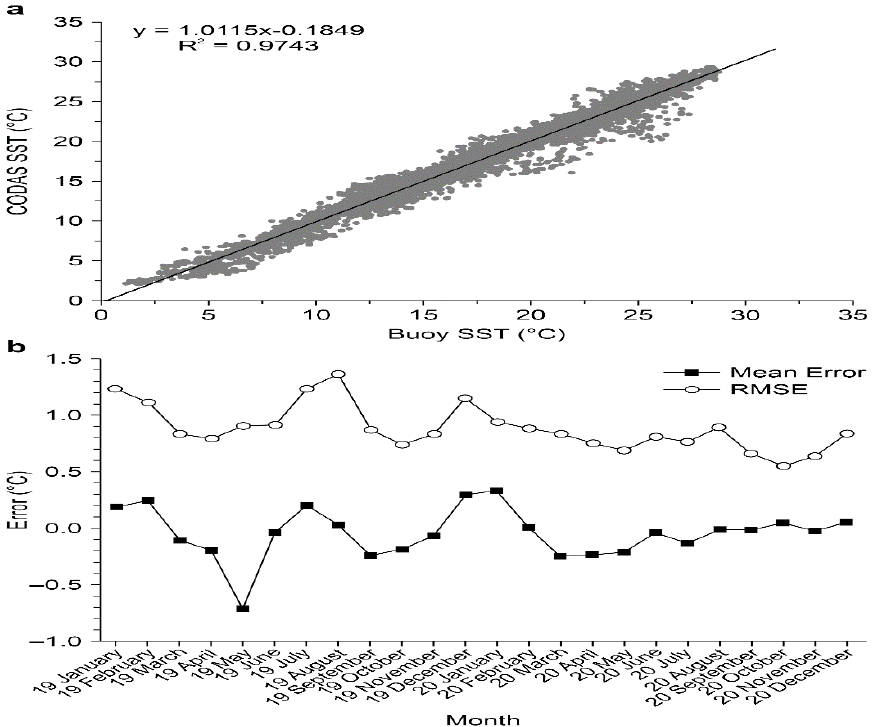
Figure 2. Verification of daily fusion SSTs. ( a ) Daily SST scatter plots of CODAS and buoy sites; ( b ) time series of the mean error and RMSE from January 2019 to December 2020.